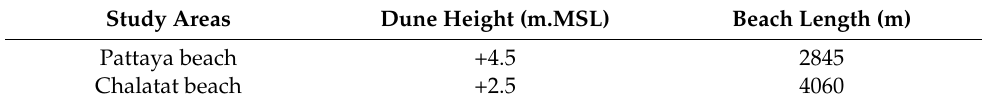
Table 5. Dune height and beach length.